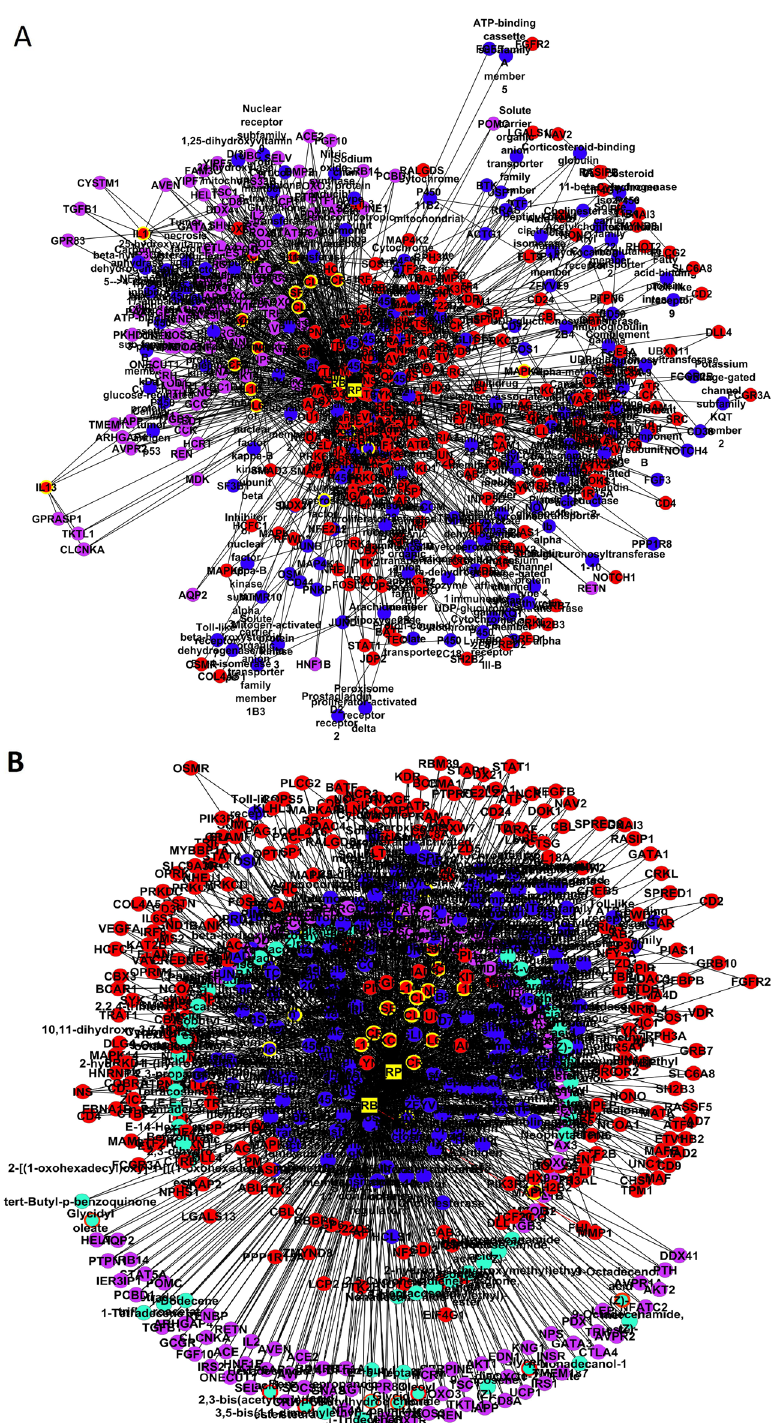
Fig. 6 (See legend on previous